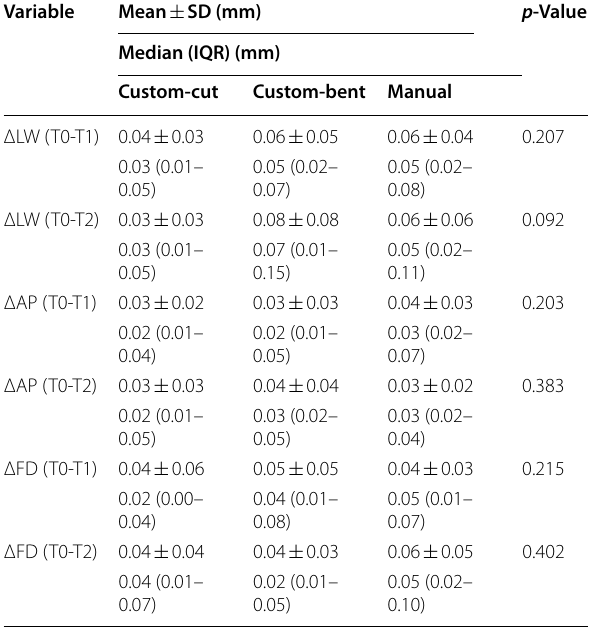
Table 1 Comparison of ΔLW, ΔAP, ΔFD in three retainer groups